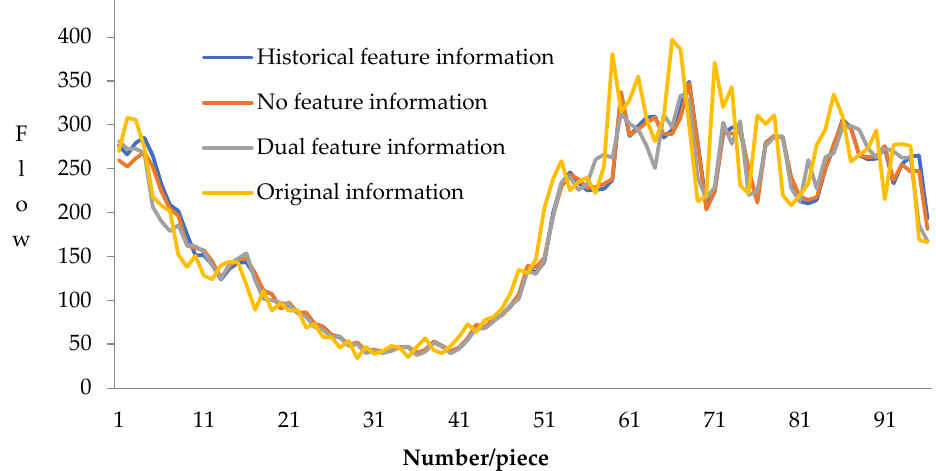
Figure 9. The GBDT feature-analysis diagram.